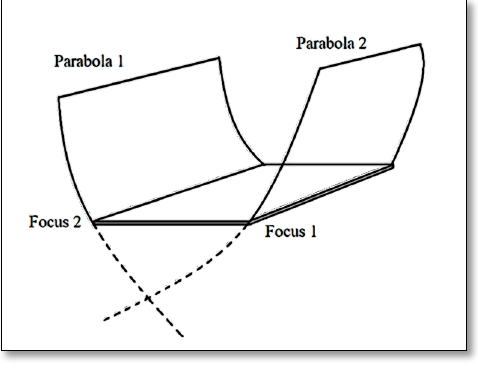
Figure 2. Winston’s Profile (CPC)